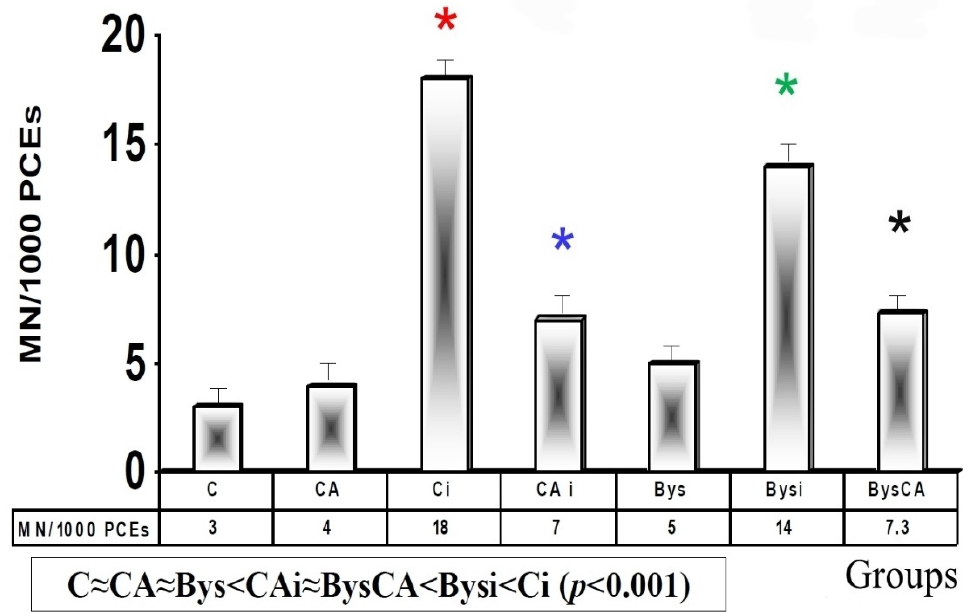
Figure 3. Frequency of micronucleated polychromatic erythrocytes (MNPCEs) in mouse bone marrow (C, control; CA, treated with carnosic acid; Ci, irradiated control; CAi, treated with CA and irradiated; Bys, treated with serum non irradiated; Bysi, treated with serum previously irradiated; BysCA, treated with irradiated serum previously treated with carnosic acid) (* p < 0.001 versus C; * p < 0.001 versus Ci; * p < 0.01 versus Ci; * p < 0.01 versus Bysi).